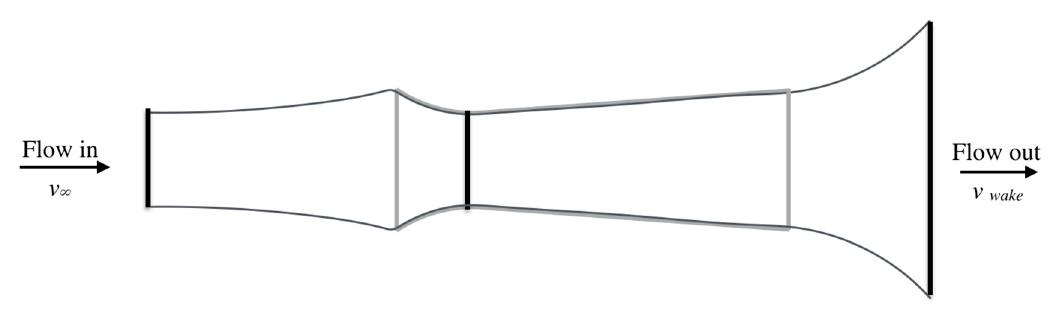
Figure 6. Control Volume described by Averaging Models (AMs).